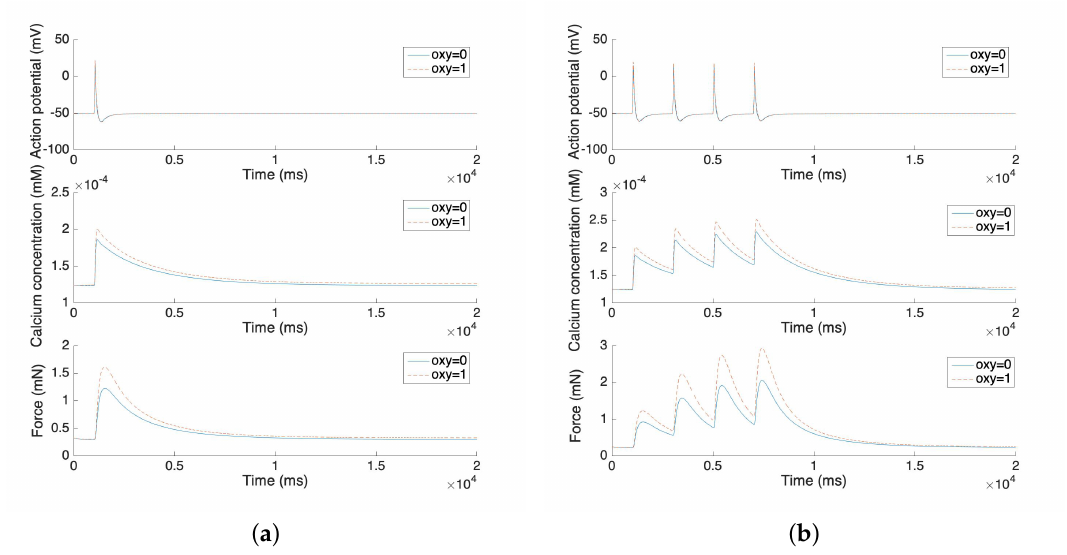
Figure 5. ( a ) Force development and oxytocin application of single spike action potential. ( b ) Force development and oxytocin application of four consecutive single spike action